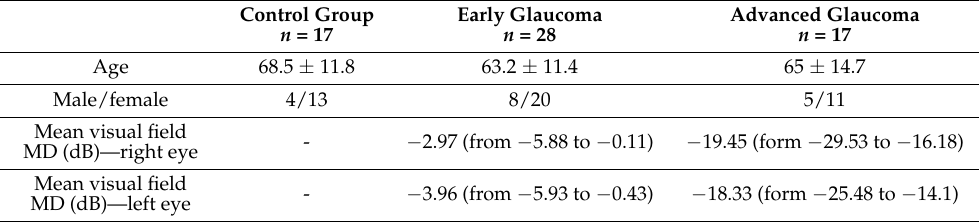
Table 1. Demographic and clinical characteristics of the studied